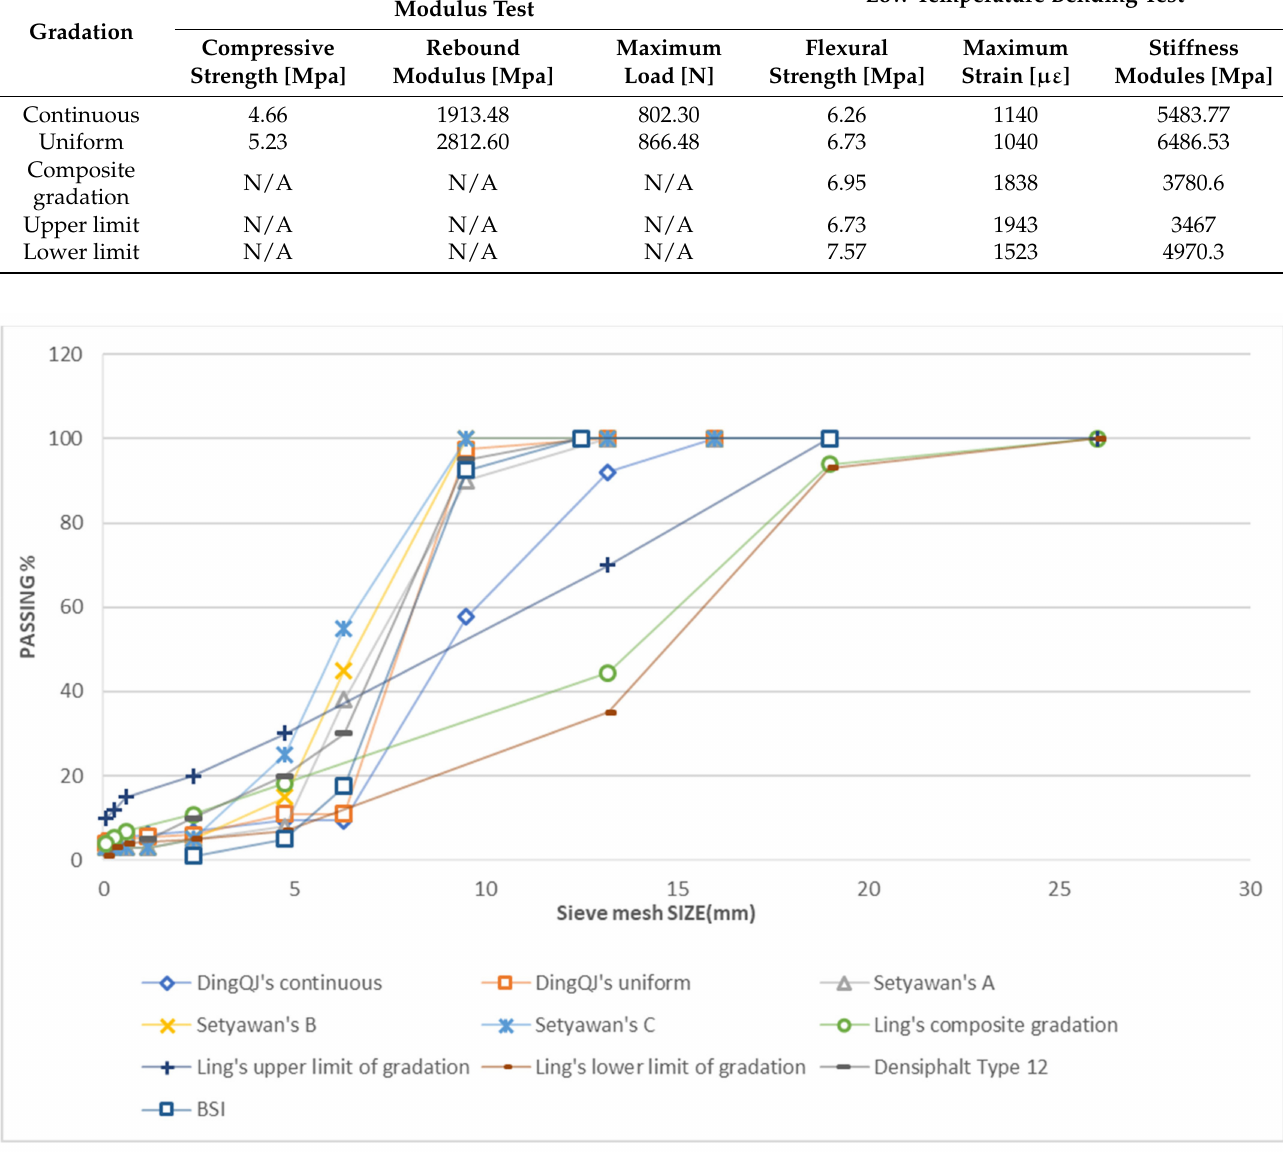
Figure 2. Some used gradations with different particle sizes and proportions. The main coarse aggregate used in GSP normally falls in a range of 4.75 mm–13.2 mm particle size. Several combinations of different tiers in this range can form OMA with the requested void rate. Under the similar void rate, gradation with a large particle